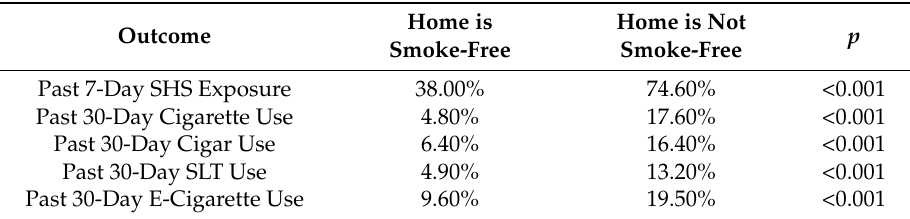
Table 3. SHS exposure and tobacco use by smoke-free home status.